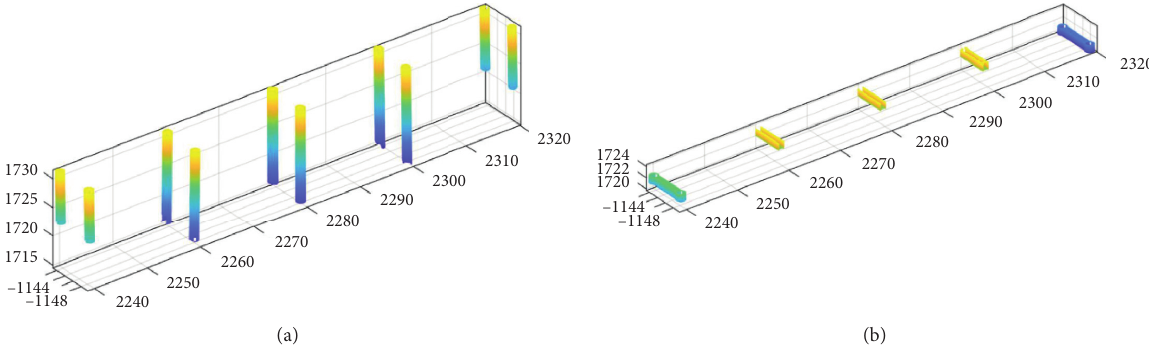
Figure 19: Tied beam and column point cloud after segmentation: (a) cylinder point cloud; (b) tie beam point